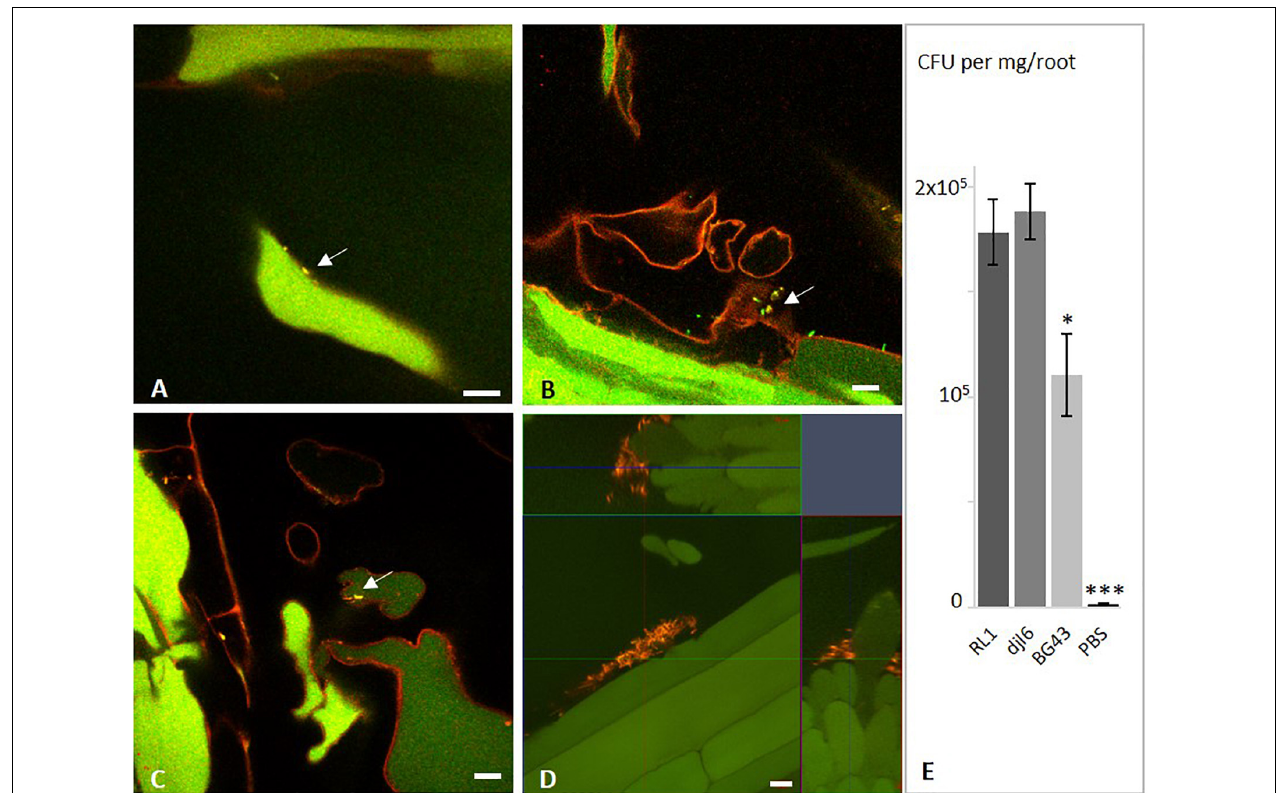
FIGURE 8 | Interaction of Rhodococcus strains RL1, BG43, and djl6 with Eruca sativa roots. In situ detection of root colonization of Eruca sativa by Rhodococcus strains visualized by fluorescence in situ hybridization (FISH). (A) RL1, (B) BG43, and (C) djl6 on 1 week old Eruca sativa roots grown in axenic quartz-sand system. (D) RL1 on 2 weeks old Eruca sativa roots grown on MS agar without additional sucrose. (E) Quantification of root colonization 1 week after inoculation. Arrows indicate bacterial cells identified by yellow color from overlaying channels of probes EUB (green) and HGC (red). Root autofluorescence is assigned in green and red. Scale bar represents 10 µ m. Significant difference is indicated by asterisks representing ∗ P < 0.05 and ∗∗∗ P <